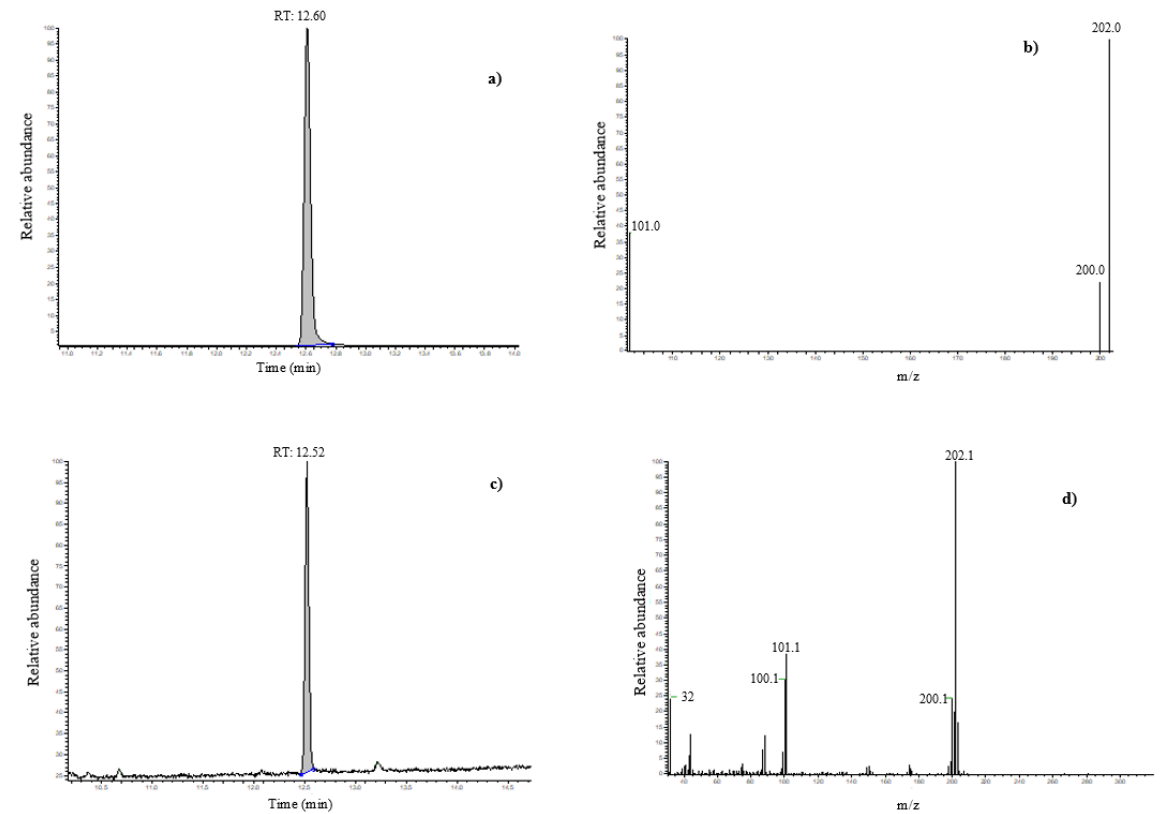
Figure 1. Analysis of pyrene degradation after five days of microbial growth. Chromatograms and fragmentogram obtained by GC–MS after pyrene extraction approaches. a) and c) standard pyrene solution; b) and d) : ITF12 ( Penicillium sp.). RT: retention